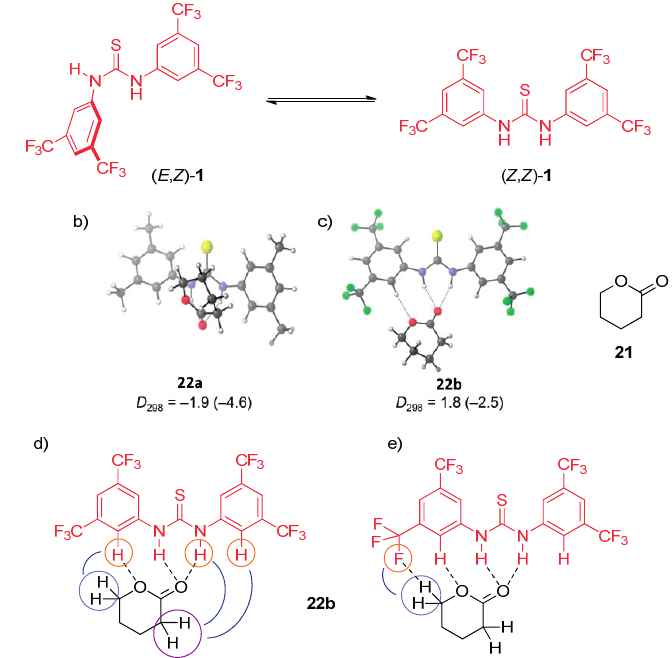
Figure 6. Conformers of thiourea 1 : ( a ) lowest-lying complex 22b , consisting of thiourea 1 and lactone 21 ; ( b ) lowest-lying complex of 1 with lactone 21 ; ( c ) important NOESY; ( d ) and 19 F– 1 H HOESY interactions in complex 22b ; ( e ) Dissociation energies ( D 298 ) are given in kcal·mol − 1 . Values with parentheses were computed with the PCM model for toluene employing UAHF radii. Adapted with permission from Ref. [30]. Copyright (2012) John Wiley and